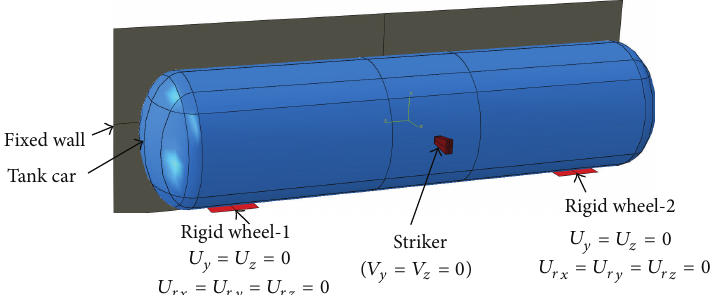
Figure 5: Schematization of the hazmat tank car impact problem.